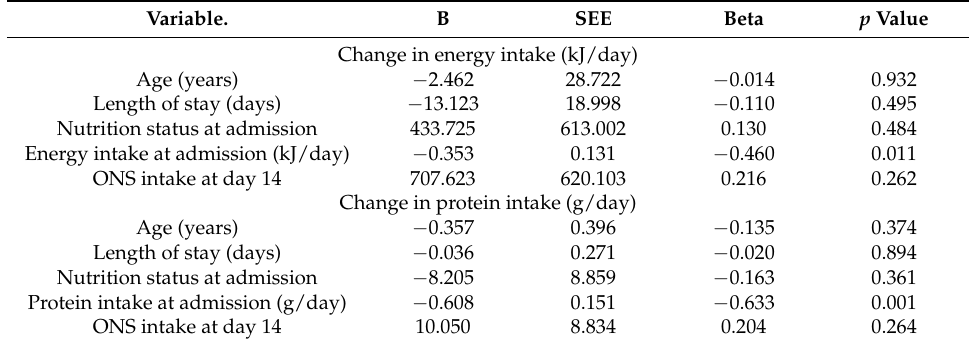
Table 2. Multiple regression models of factors associated with change in energy (kJ/day) and protein (g/day) intake between admission and day 14 of subacute inpatient stay ( n = 39). Variable. B SEE Beta p Value Change in energy intake (kJ/day) − 2.462